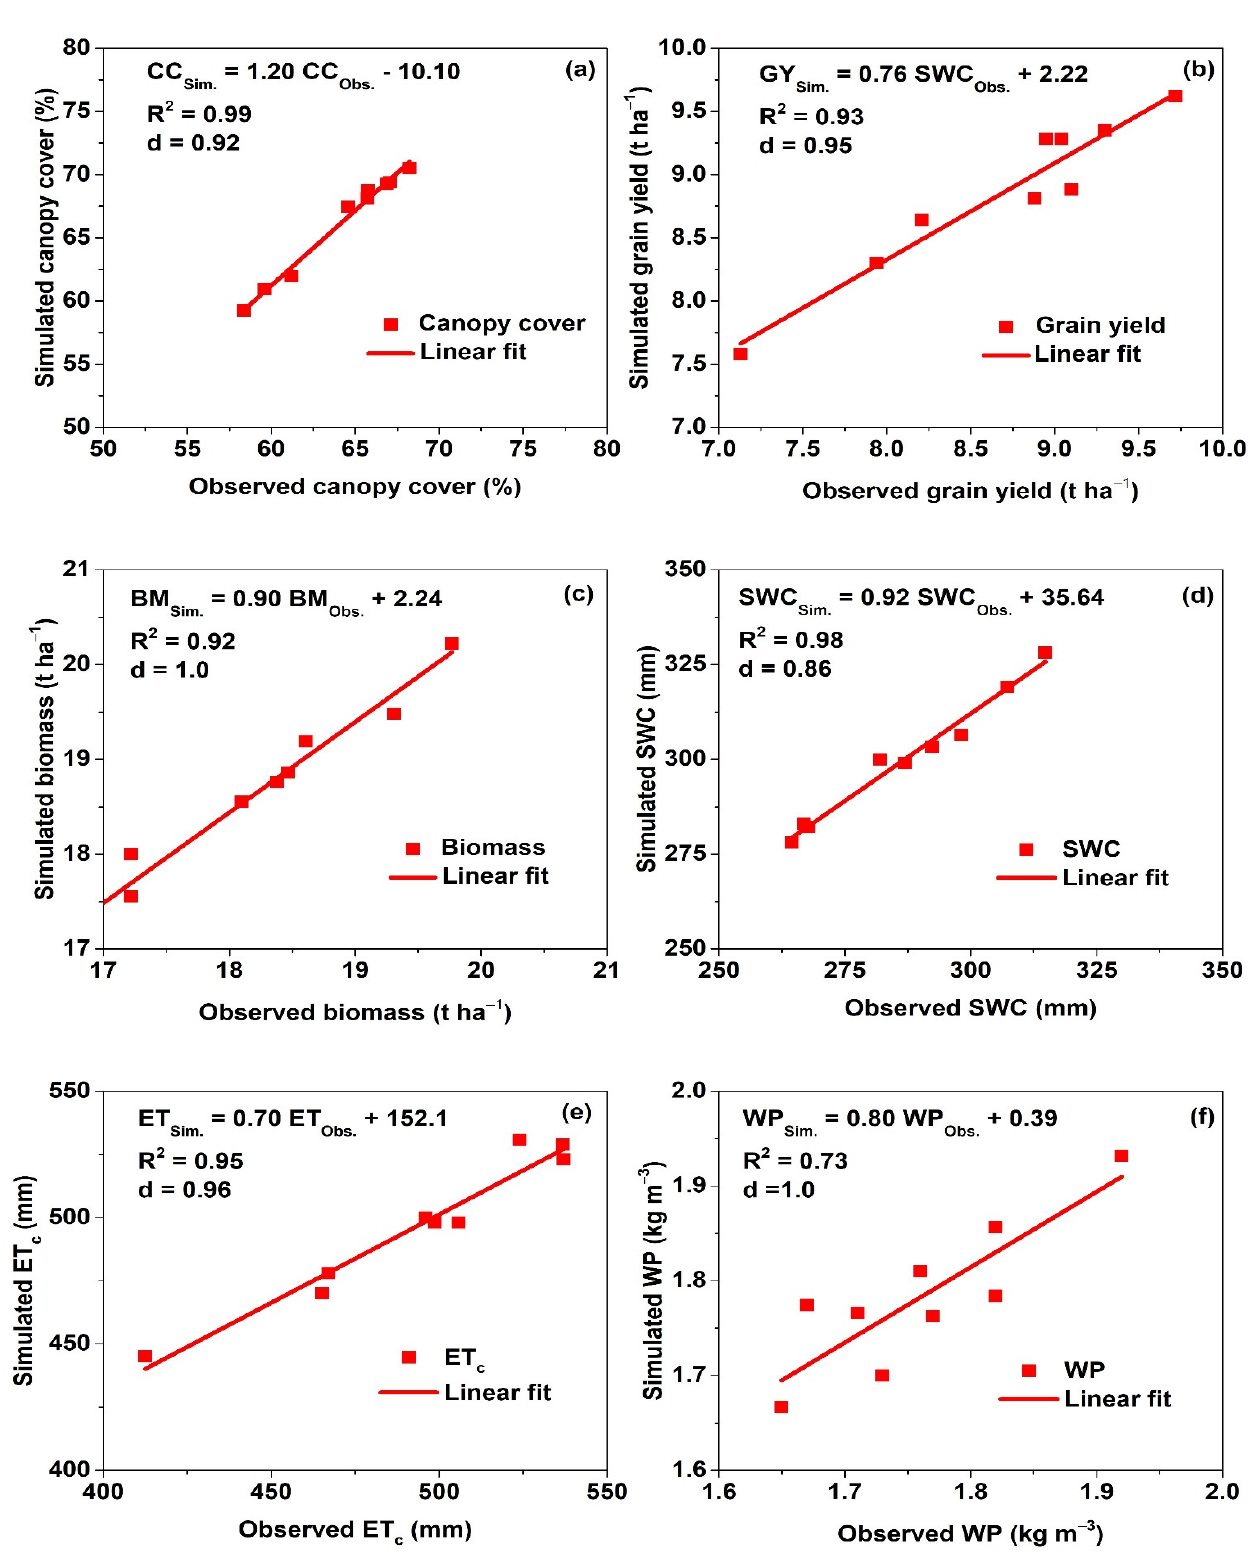
Figure 6. The relation between observed and simulated values for canopy cover ( a ), grain yield ( b ), biomass ( c ), soil water content SWC ( d ), crop evapotranspiration ET c ( e ), and water productivity WP ( f ) under all treatments in 2017 − 2018 under model validation.